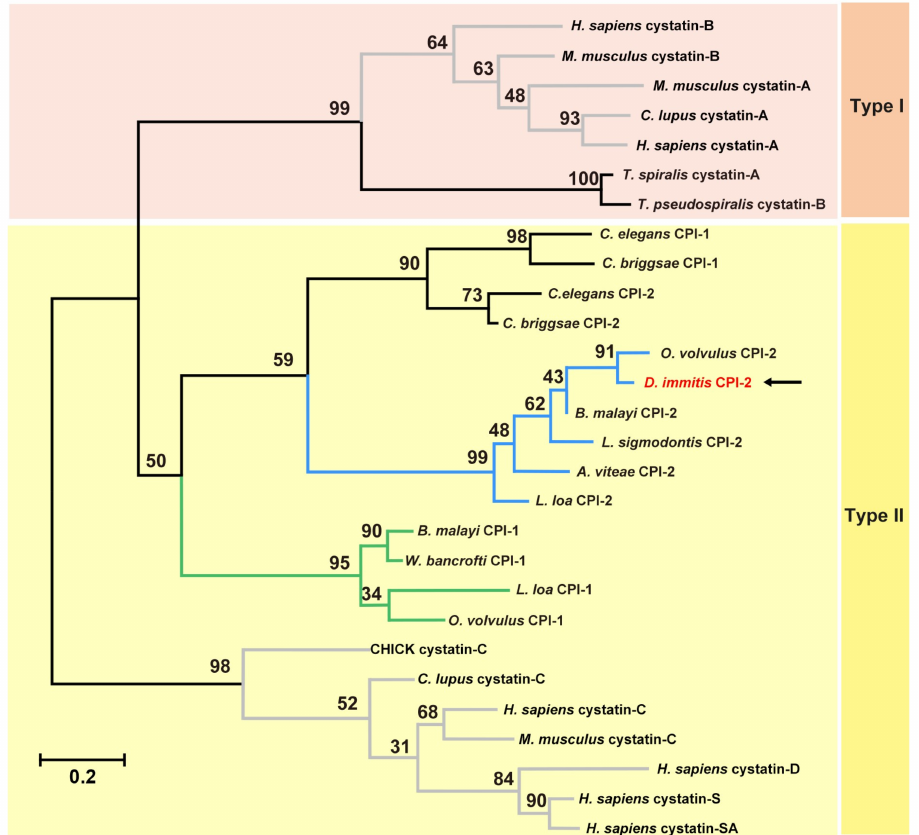
Figure 2. Phylogenetic relationships between Di -CPI and homologous cystatins / CPIs. The tree was constructed from a multiple sequence alignment performed using Clustal W2 and plotted using MEGA 6.06. Amino acid sequences used in the tree, with their GenBank accession numbers, are as follows: Homo sapiens cystatin-B, NP_000091.1; Mus musculus cystatin-B, NP_001076014.1; Mus musculus cystatin-A, NP_005204.1; Canis lupus familiaris cystatin-A, SPO16019.1; Homo sapiens cystatin-A, NP_005204.1; Trichinella spiralis , KRY35881.1; Trichinella pseudospira , KRZ14801.1; Caenorhabditis elegans CPI-1, NP_500915.1; Caenorhabditis briggsae CPI-1, CAP25989.2; Caenorhabditis elegans CPI-2, AF068718.1; Caenorhabditis briggsae CPI-2, CAP29292.1; Onchocerca volvulus CPI-2, | P22085.2; Brugia malayi , AAD51086.1; Litomosoides sigmodontis , AAF35896.1; Acanthocheilonema viteae , AAA87228.1; Loa loa CPI-2, XP_003147913.1; Loa loa CPI-1, XP_003136654.1; Brugia malayi CPI-2, U80972.1; Wuchereria bancrofti , EJW82673.1; Onchocerca volvulus CPI-1, AF177194.1; CHICK, P01038.2; Canis lupus familiaris cystatin-C, XP_003639869.1; Homo sapiens cystatin-C, P01034.1; Homo sapiens cystatin-D, P28325.1; Homo sapiens cystatin-S, P01036.3; Homo sapiens cystatin- SA, P09228.1. Numbers indicate bootstrap values. The branches in grey and in black represent mammalian cystatins and nematode cystatins, respectively. In addition, the green and blue branches represent first subgroup of filarial cystatins and the second subgroup of filarial cystatins, respectively. The pink and yellow backgrounds represent type I and type II cystatins,